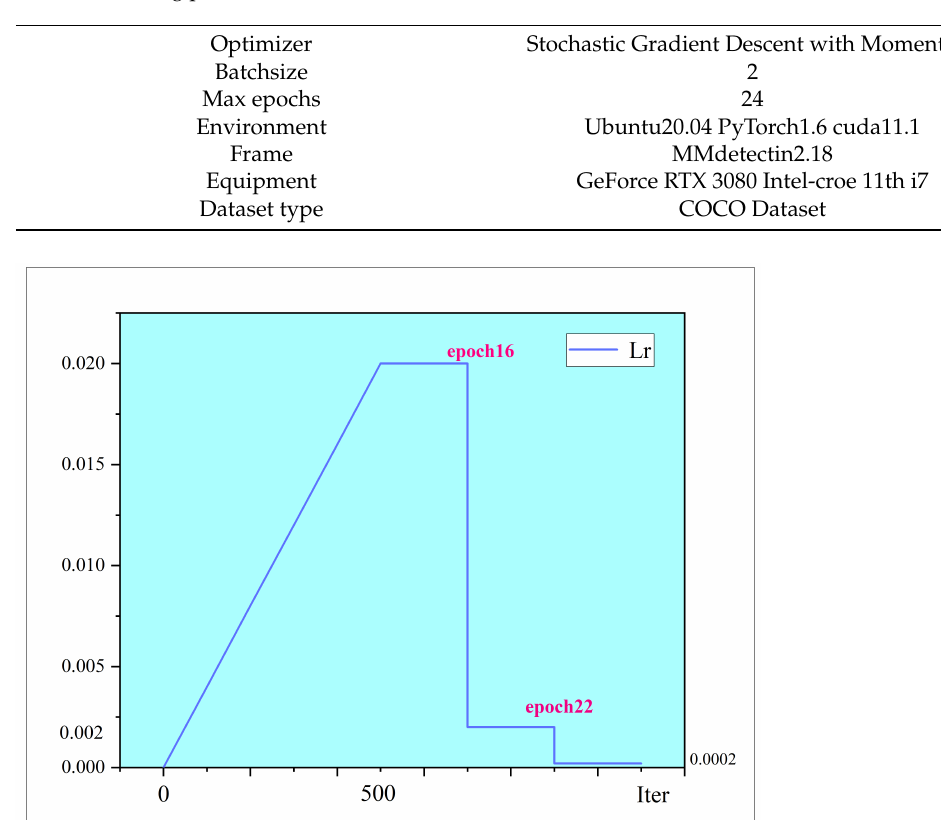
Table 1. Training parameters and details.